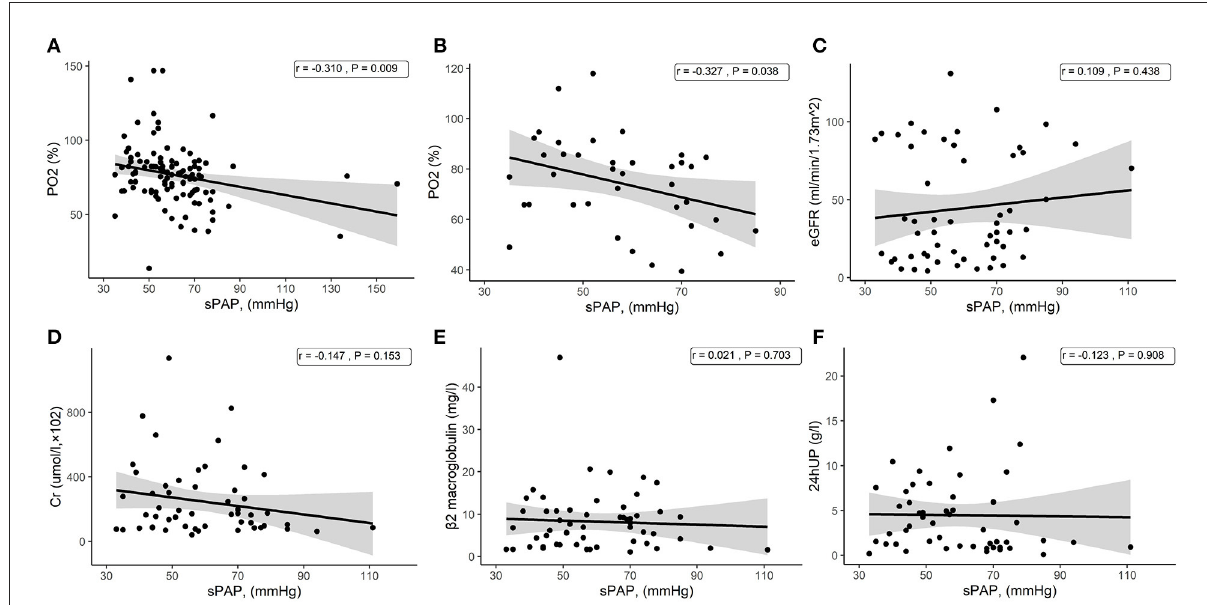
FIGURE3 Scatter plots from the correlation analysis. (A) Correlation between sPAP and PO 2 among all patients with PH in CKD. (B) Correlation between sPAP and PO 2 among patients with PH in CKD without dialysis treatment. (C) Correlation between sPAP and eGFR among patients with PH in CKD without dialysis treatment. (D) Correlation between sPAP and Cr among patients with PH in CKD without dialysis treatment. (E) Correlation between sPAP and β 2 macroglobulin among patients with PH in CKD without dialysis treatment. (F) Correlation between sPAP and 24hUP among patients with PH in CKD without dialysis